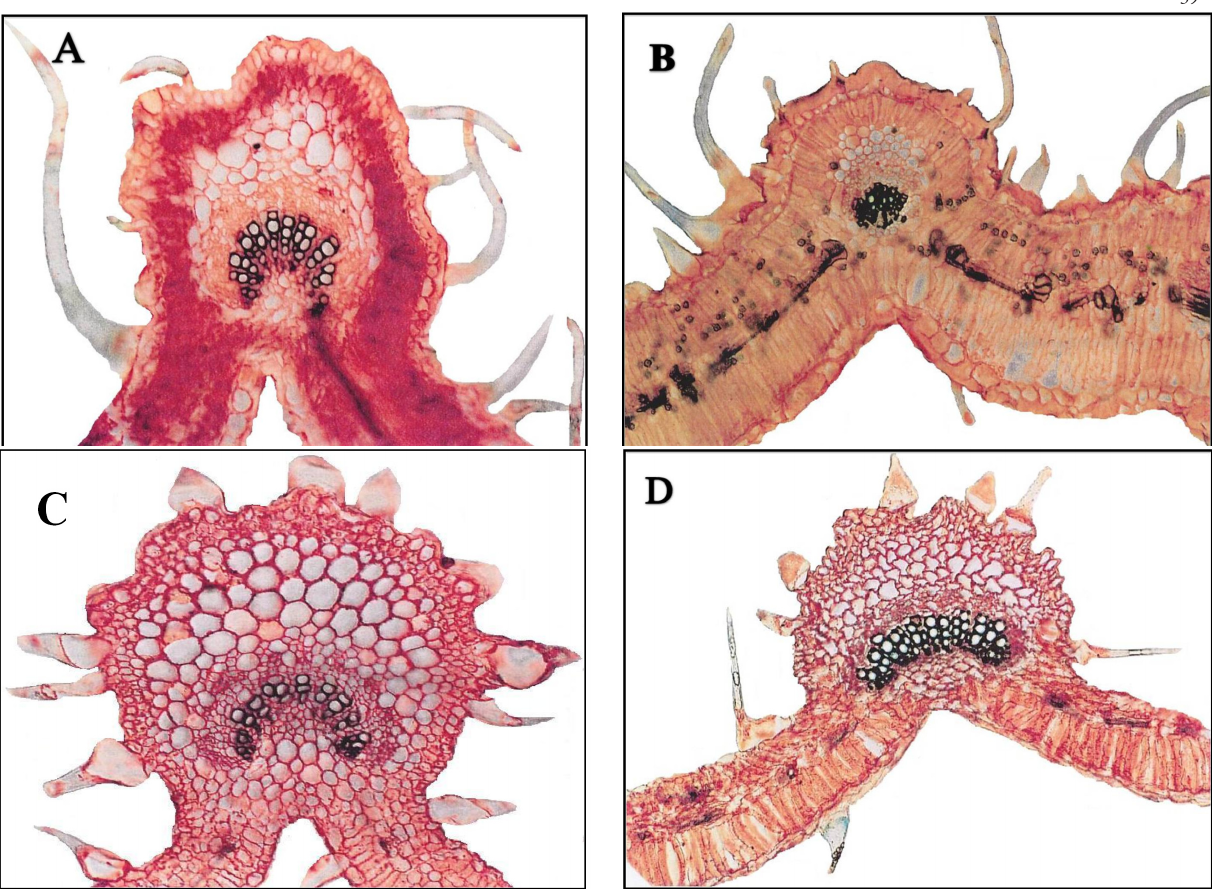
Fig. 3. Midrib of Heliotropium species in T.S; H. aucheri (A); H. carmanicum (B); H. lasiocarpum (C); H. suaveolens